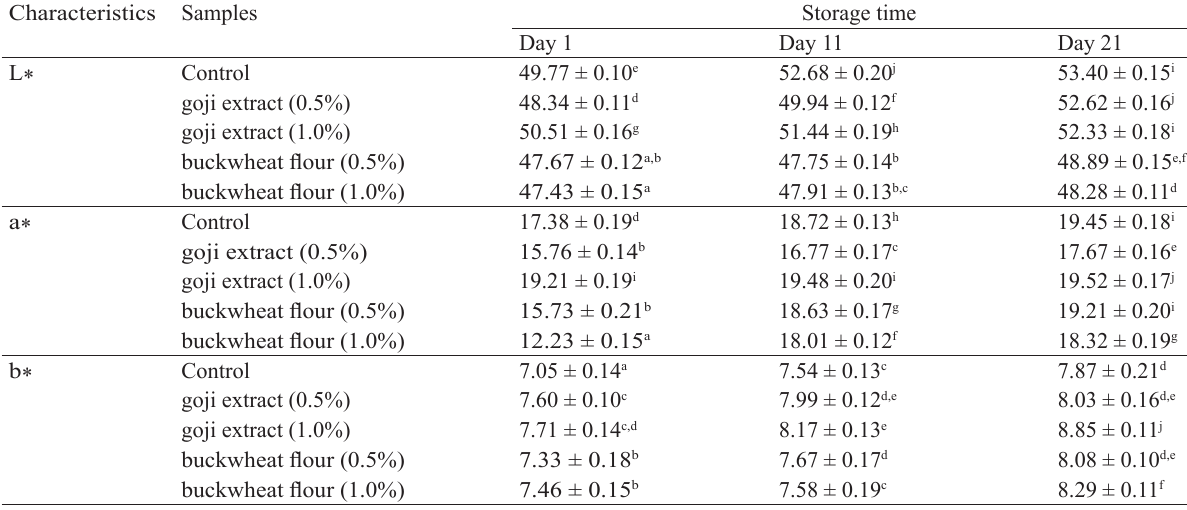
Table 2. Surface color characteristics (L*, a*, b*) of the cross-section of the of vacuum-packaged samples during 21 days of storage at 0–4°C Characteristics